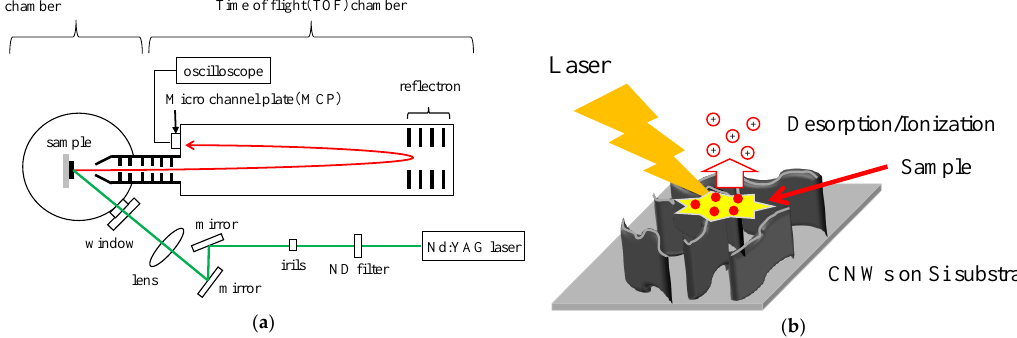
Figure 3. Schematic diagram of ( a ) surface-assisted laser desorption / ionization time-of-flight mass spectrometry (SALDI-TOF-MS) system; ( b ) illustration of desorption / ionization process on